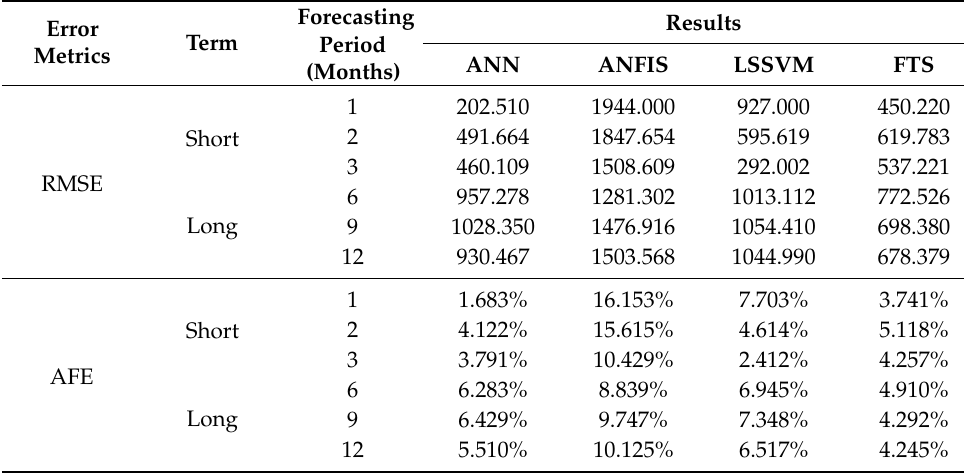
Table 8. Short-term and long-term forecasting results for